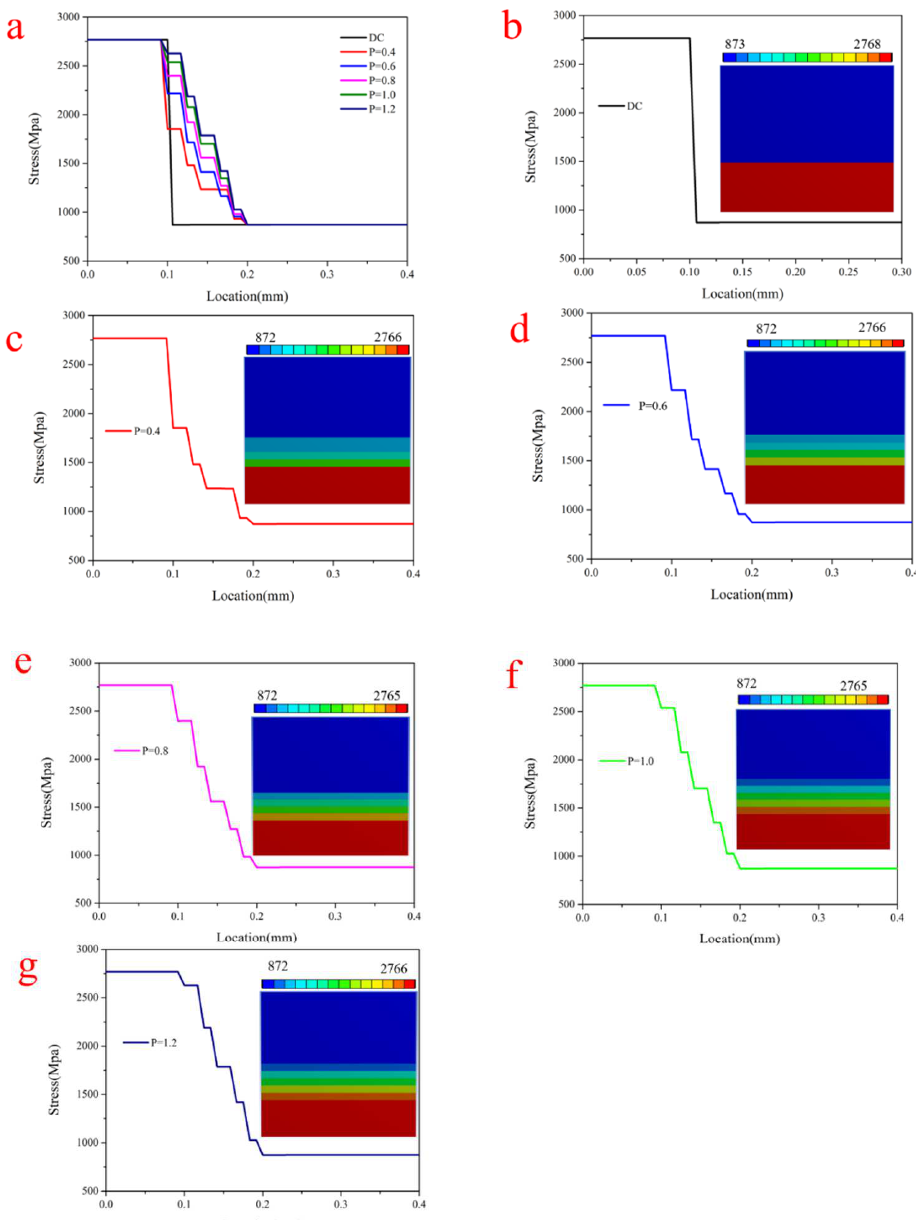
Figure 5. Stress distribution of the model along the vertical axis of symmetry ( a ), thermal stress distribution of traditional coating ( b ) and S1 ( c – g ).